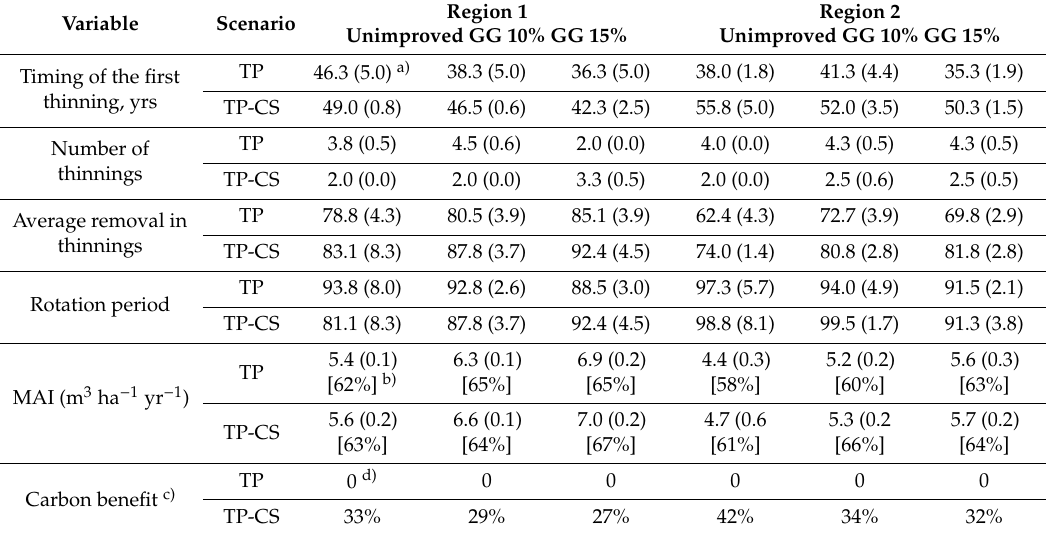
Table 1. Resulting values of relevant variables in stand-level optimizations with the objective function of timber production (TP) or joint production of sequestered carbon and timber (TP-CS). See Figure 1 for the locations of Regions 1 and 2. Social cost of carbon € 35 tonCO 2 ; discount rate 2%. “GG” refers to genetic